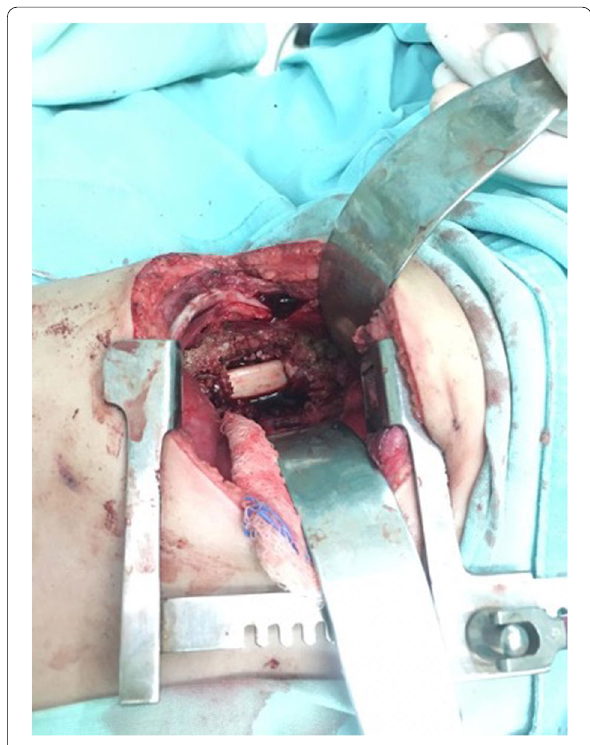
Fig. 4 Thoracotomy with corpectomy of vertebrae D7 and D8 and placement of fibula allograft between vertebrae D6 and D9